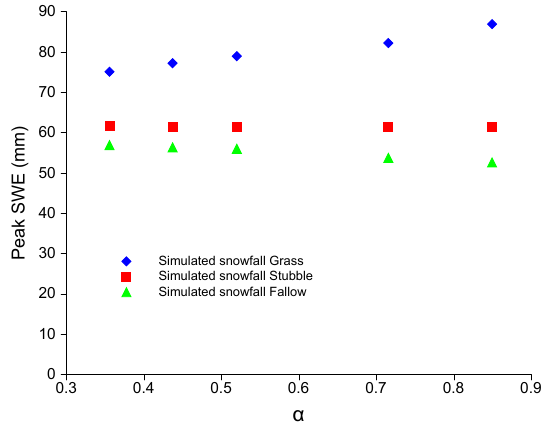
Fig. 11. Variation in simulated peak snowfall vs. α for simulated snowfalls on fallow, stubble and grass HRUs. Measured snowfall data from Saskatoon, SK,